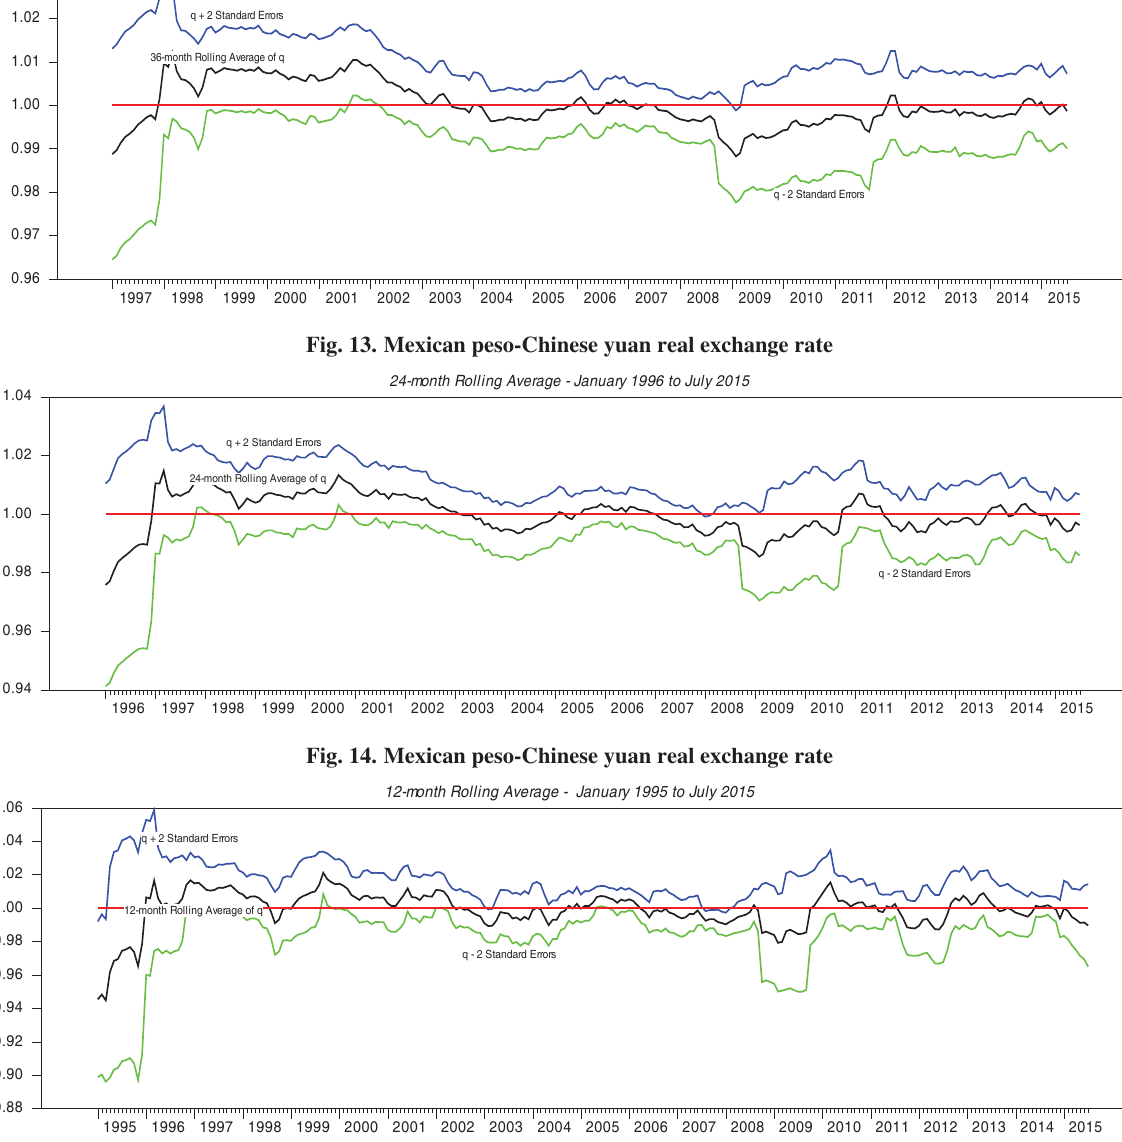
Fig. 15. Mexican peso-Chinese yuan real exchange